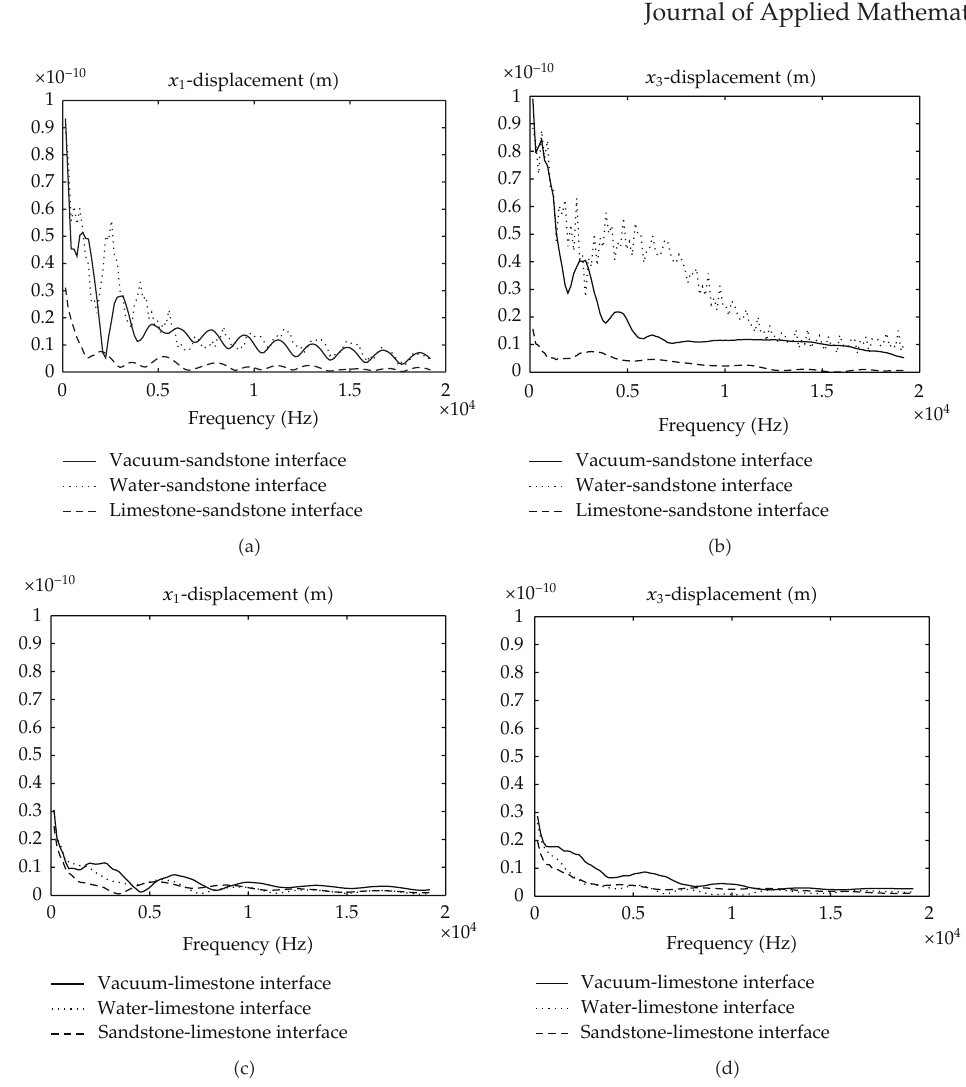
Figure 3: Spectra of displacement for three interface models. Results for Materials 1 (cid:2) see Table 1 (cid:5) are plotted (cid:2) a (cid:5) and (cid:2) b (cid:5) , while those obtained from Materials 2 are presented in (cid:2) c (cid:5) and (cid:2) d (cid:5)